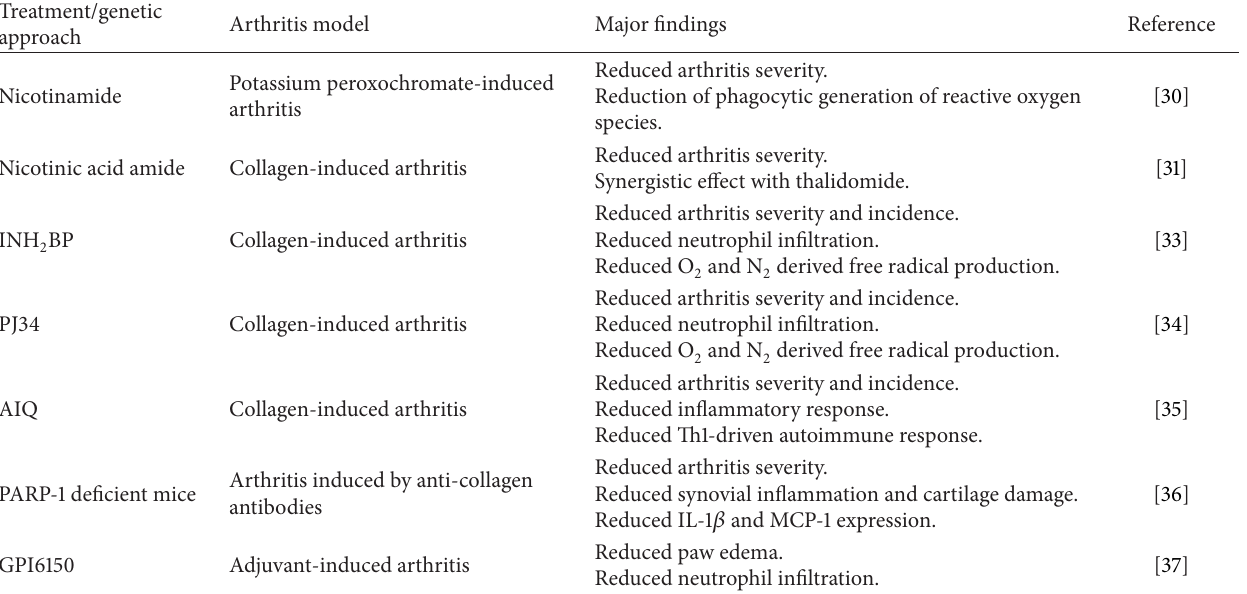
Table 1: Effect of PARP inhibition/deletion in experimental